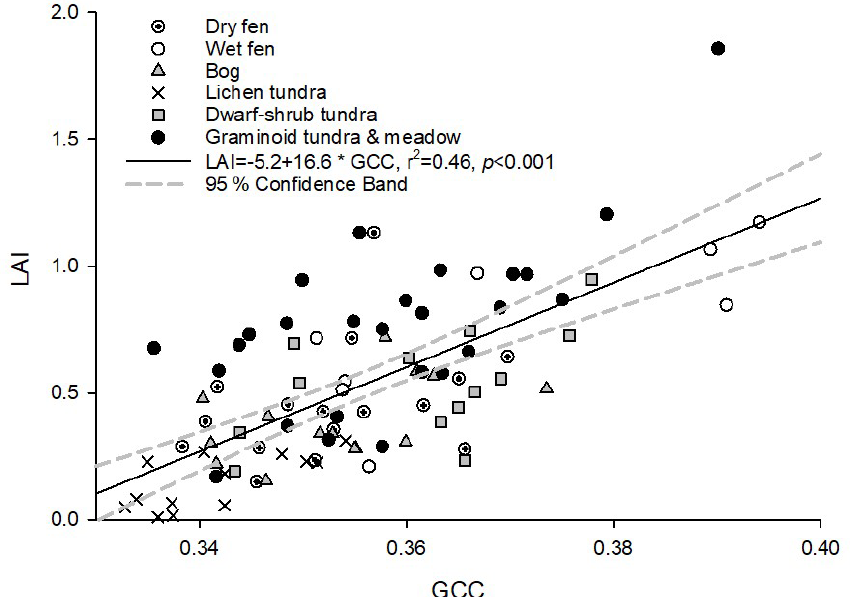
Figure A3. Relationship between GCC and vascular plant LAI in the harvested plots. LCTs are indicated with symbols. In the LCT-specific regressions (not shown), the coefficient of determination ( R 2 ) was lowest for dry fen (0.06) and highest for wet fen (0.54). Regression adj . slopes varied from 8.3 for dry fen to 17.8 for the combined graminoid tundra and meadow